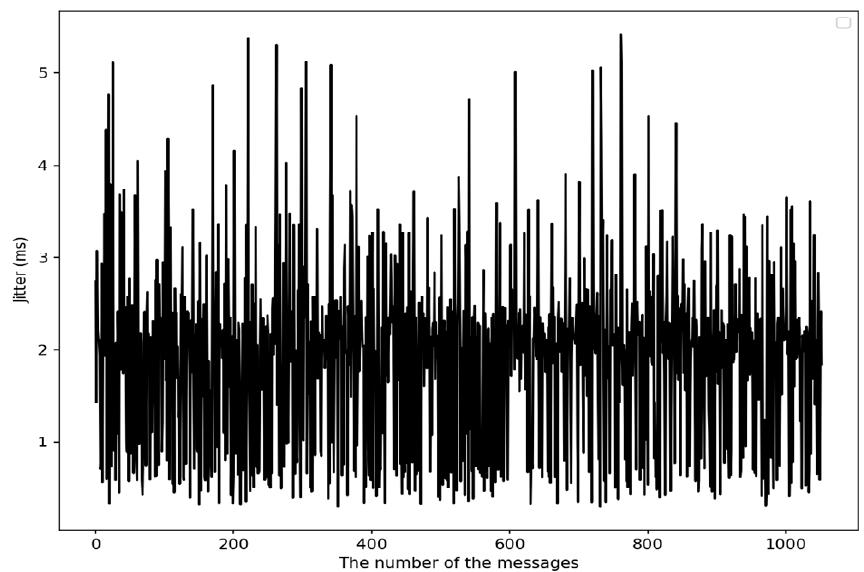
Figure 7. Jitter of the lowest CAN message transmitted over the CAN bus.